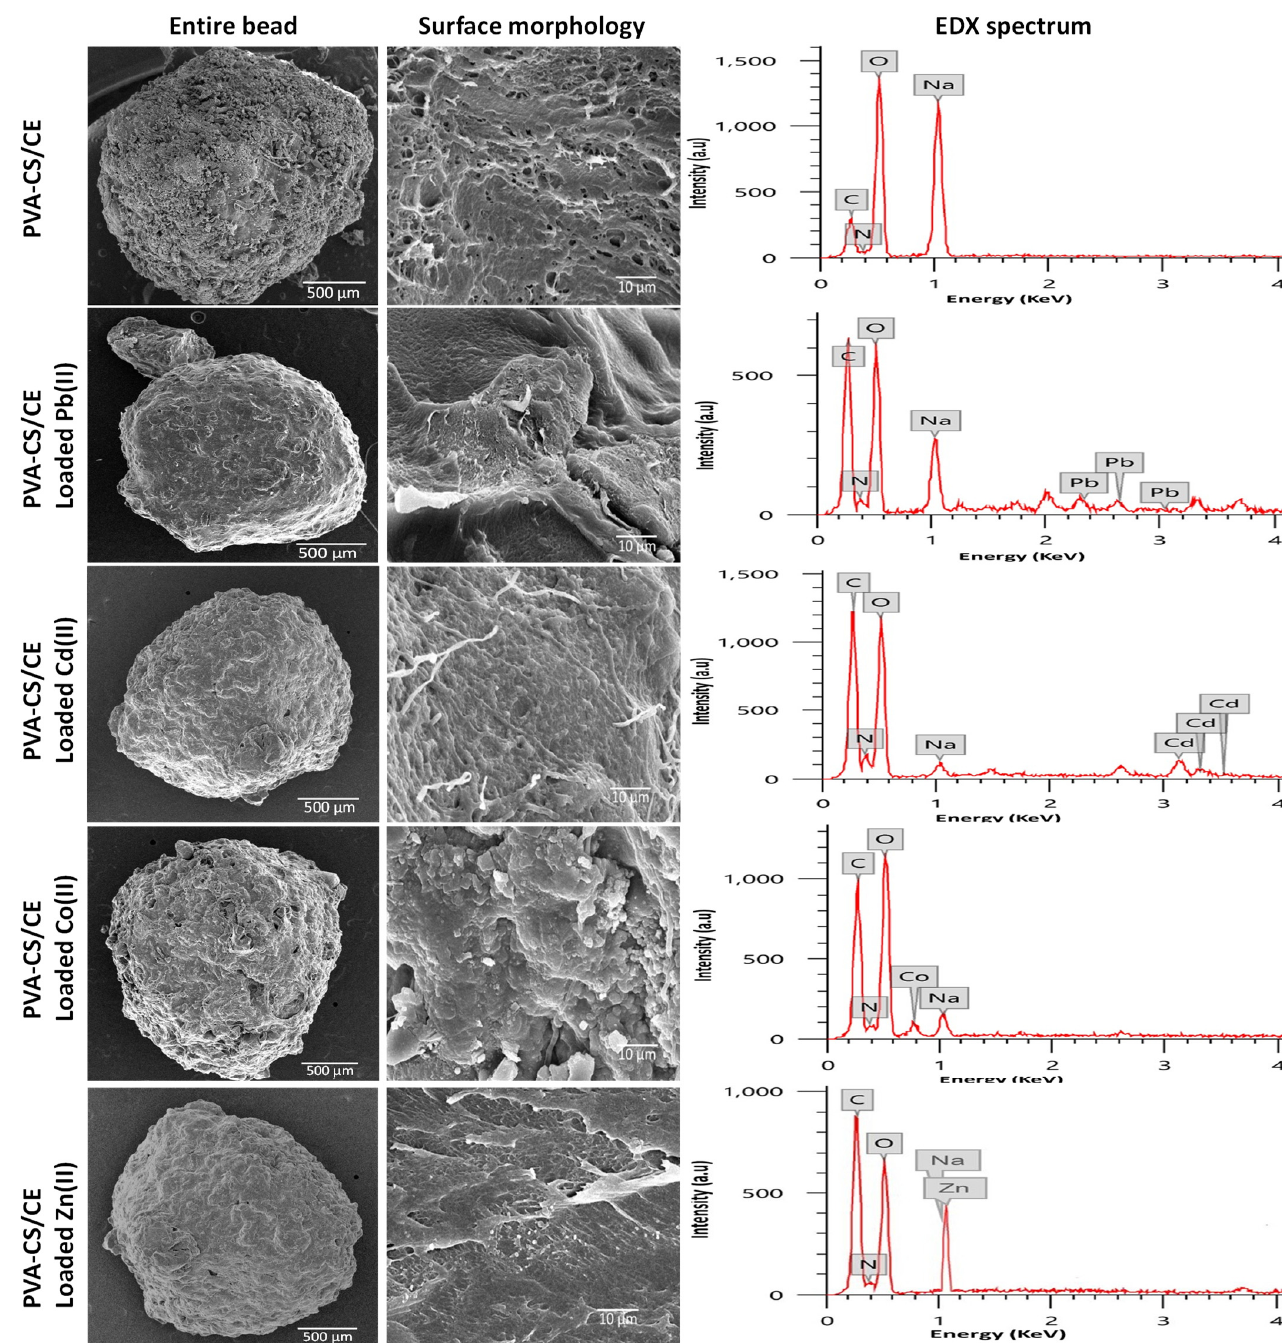
Figure 4. SEM images of the entire surface of PVA-CS/CE hydrogel beads before and after adsorp- tion of heavy metal ions as well as EDX spectra of PVA-CS/CE hydrogel beads. of heavy metal ions as well as EDX spectra of PVA-CS/CE hydrogel